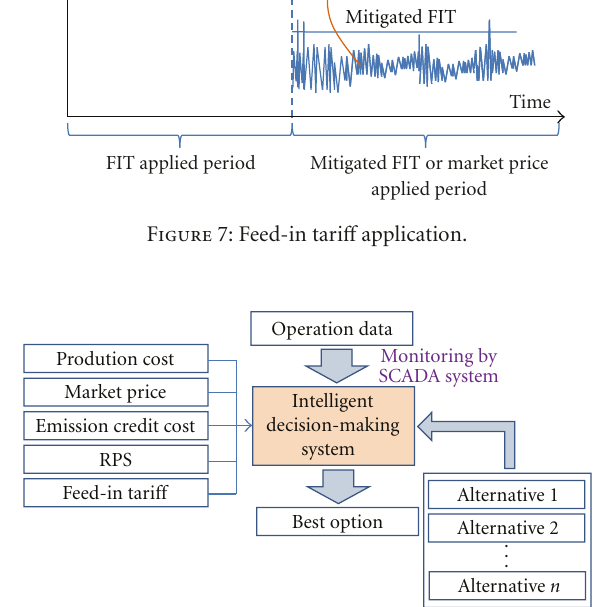
Figure 8: Intelligent decision-making